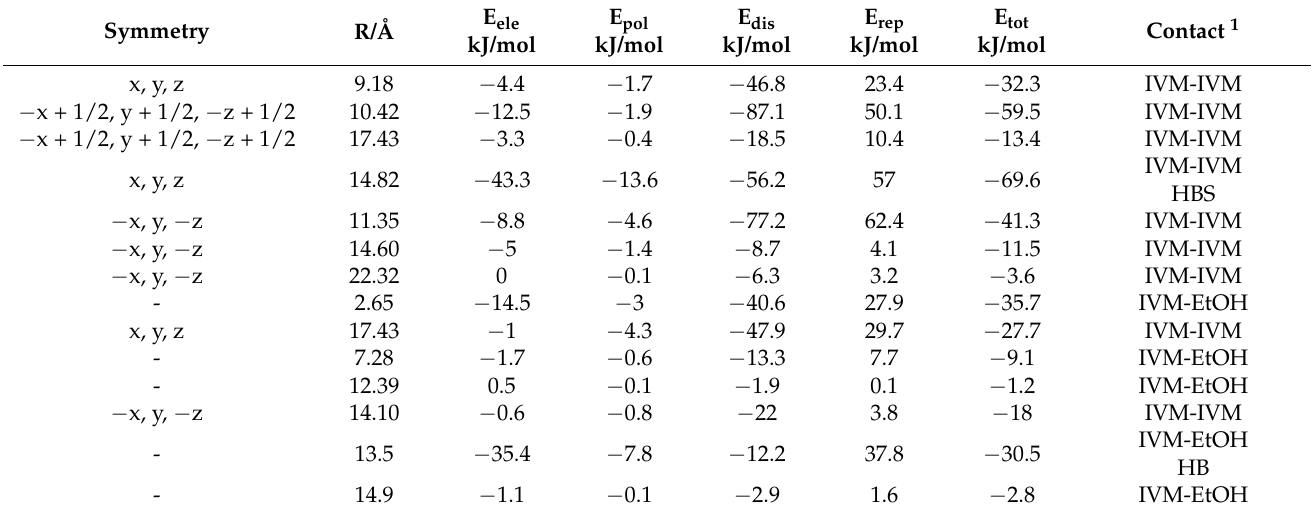
Table 2. The pairwise total interaction energy (E tot ) and its components (electrostatic (E ele ), polarization (E pol ), dispersion (E dis ) and exchange-repulsion (E rep ) energy terms) for the closest molecule pairs (having atoms within 3.8 Å radius from the central molecule) for IVM-ethanol solvate I calculated in